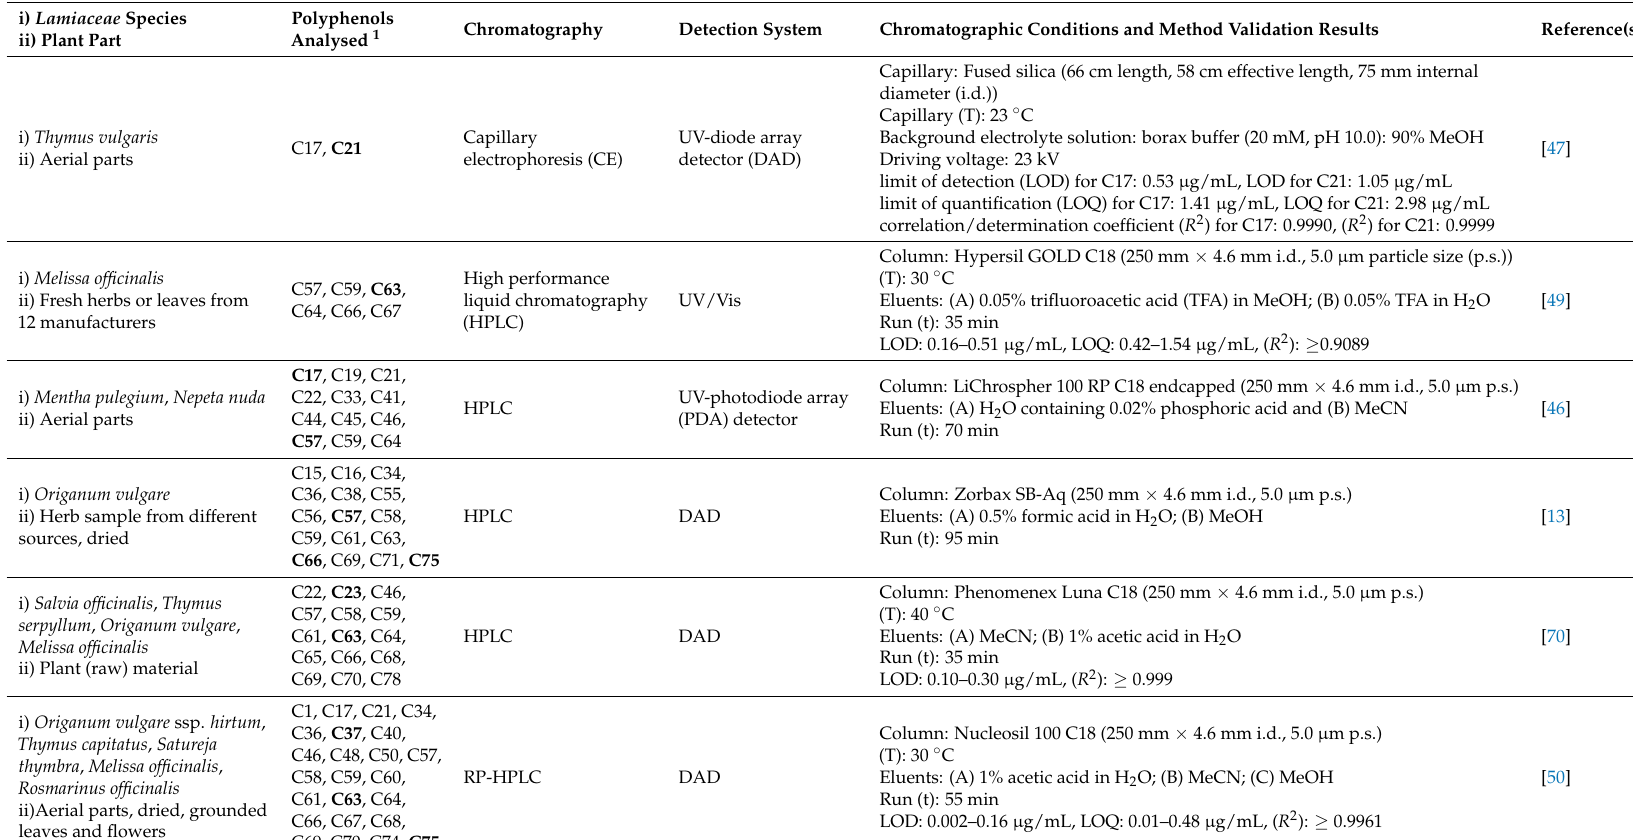
Table 2. Recent applications of conventional and hyphenated chromatographic methods for phenolic constituents in Lamiaceae